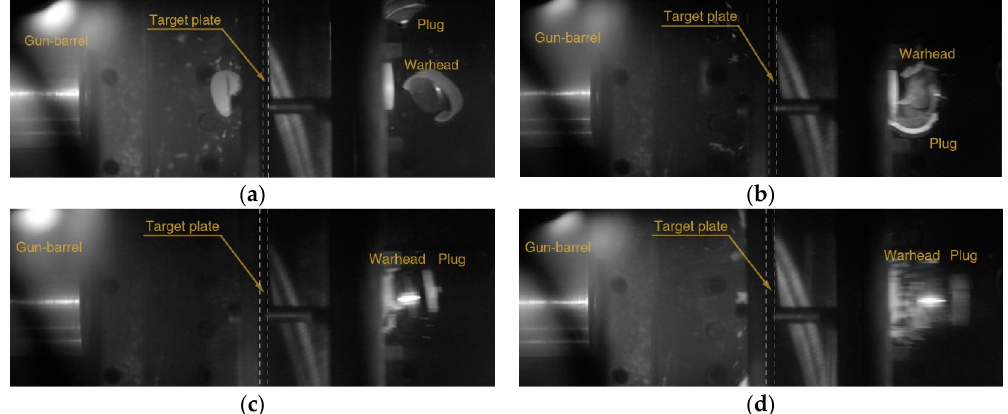
Figure 3. Perforations through 5 mm 7075-T651 plates showing the residual velocities of ( a ) 111.2, ( b ) 144.4, ( c ) 276.2, and ( d ) 348.3 m/s by projectiles at the initial velocities of ( a ) 163.2, ( b ) 187.4, ( c ) 298.8, and ( d ) 372.8 m/s.